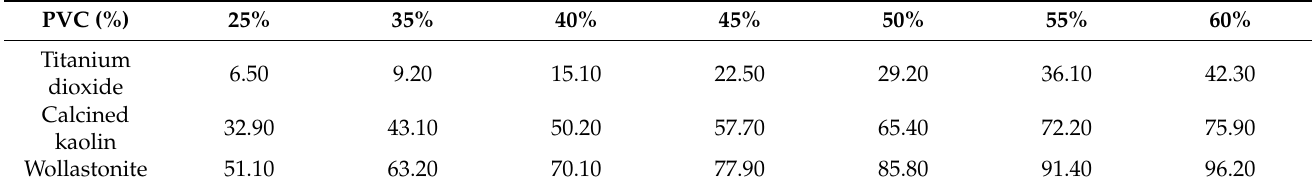
Table 4. The pigment volume concentrations (PVCs) in formulations for Design 2.